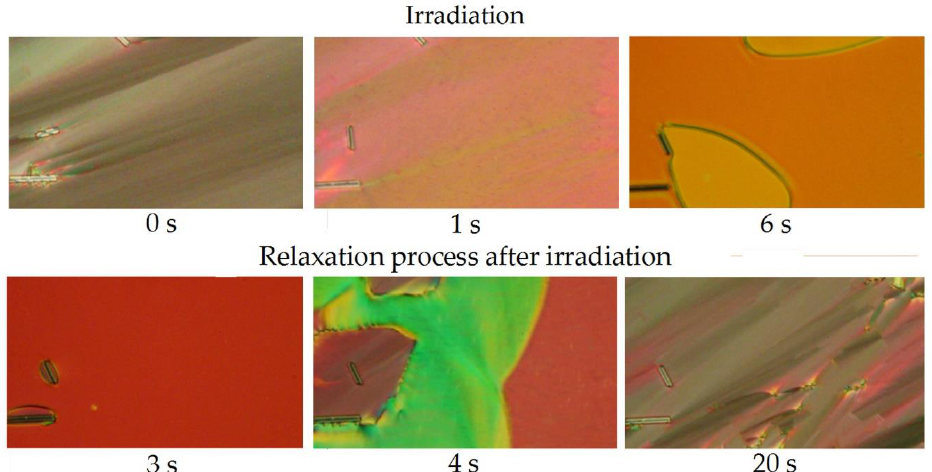
Figure 7. Photos of structural changes in SmA* mesophase of the material IIb in a planar ITO-cell at 160 ◦ C observed in POM: before irradiation (0 s); during UV-light (365 nm) irradiation in time (1–6 s) and after irradiation (relaxation process) (3–20 s). The whole transition is documented in a supplementary video file